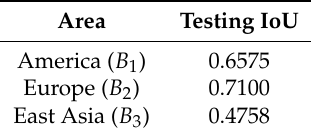
Figure 11. Samples from the cities of Seoul, Shanghai, and Tokyo in area B 3 . The figures of ( a , f , k ) are the sample images, and the figures of ( b , g , l ) colored in red are the ground truth of images. The figures of ( c , h , m ) colored in green are the prediction of GeoBoost. The figures of ( d , i , n ) are the center crop of labels, and the figures of ( e , j , o ) are the center crop of GeoBoost’s prediction. The first three columns are with a size of 4096 × 4096, and the last two is the center crop of the big images for observing details with a size of 1024 × 1024. Table 3. Results for the comparison of different areas on the test set. The coverage of different areas are the same as the bounding boxes of B 1 , B 2 , and B 3 in Figure